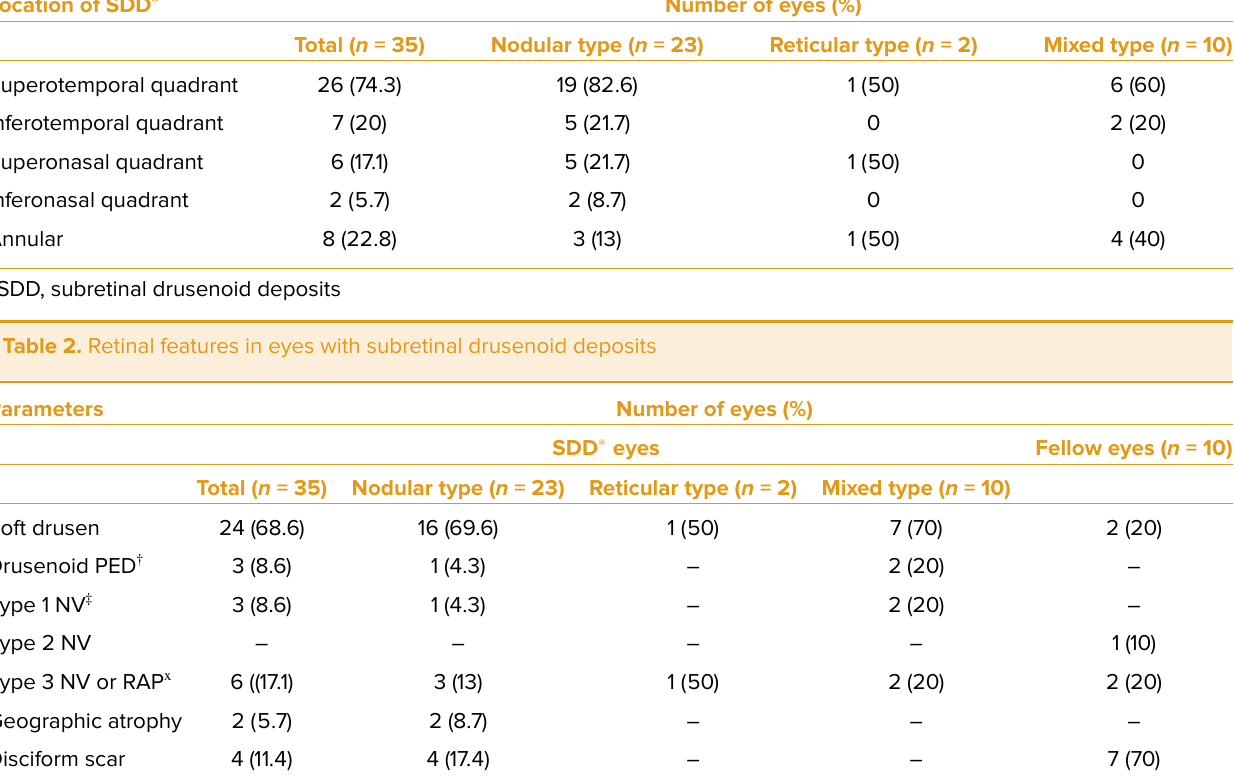
Figure 6. Swept source-based choroidal imaging in eyes with SDD (a–d). While “a” and “d” show near-normal choroidal morphology, the choroid is severely thinned out in “b” and “c”. The subfoveal choroidal thickness was 166, 74, 115, and 244 in “a”, “b”, “c”, and “d”, respectively. Table 1. Spatial distribution of subretinal drusenoid deposits or pseudodrusen Location of SDD ∗